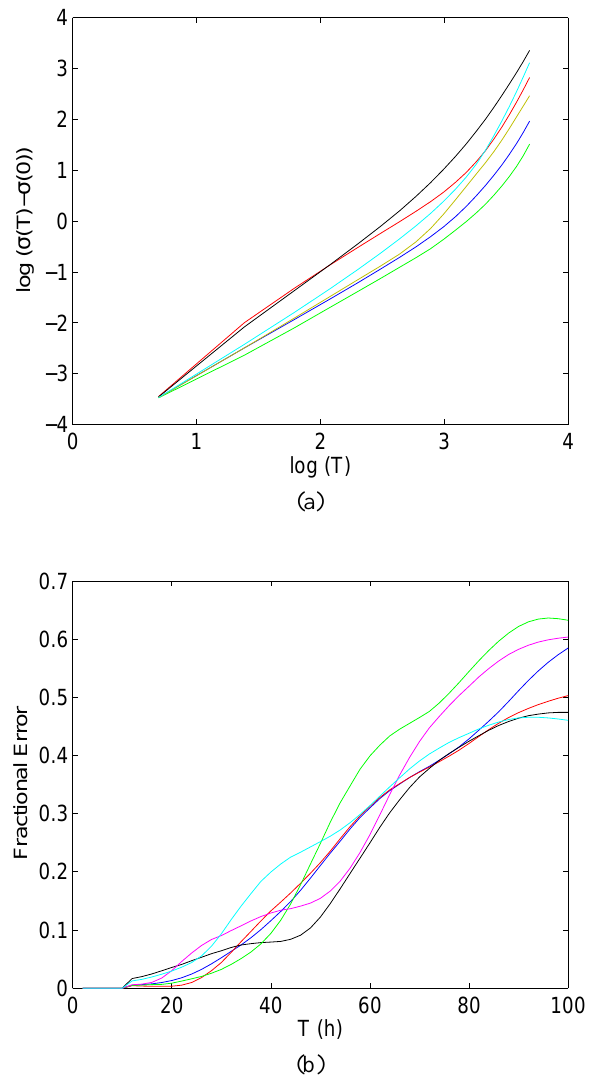
Fig. 11. Log-log plots of the RMS displacement versus integration time T for FRD (a), and error estimates (b).